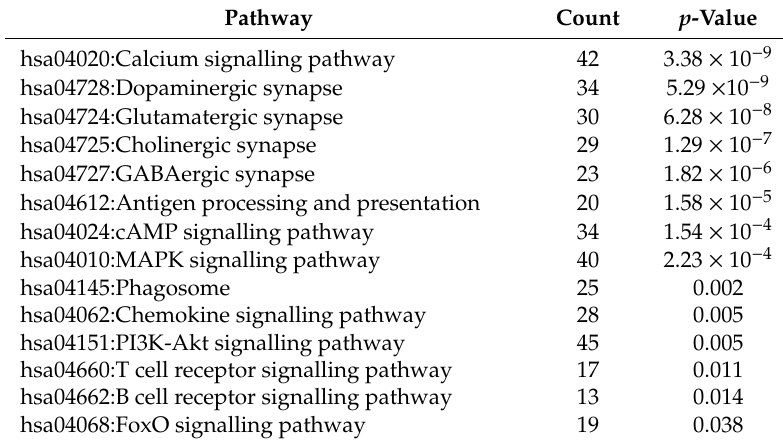
Table 2. KEGG pathway analysis of “pre-lesional” versus control white matter transcriptomic datasets. Pathway Count p